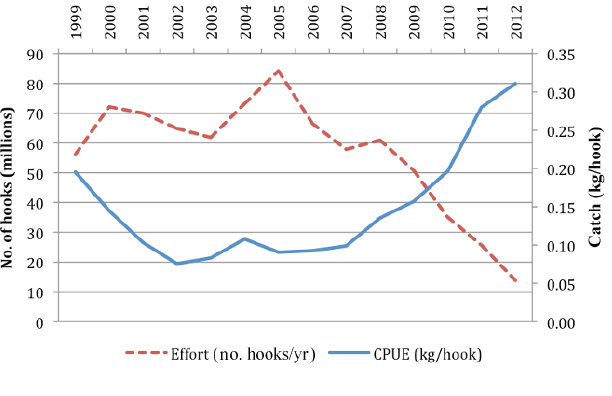
Fig. 3 . Effort and commercial catch per unit of effort (CPUE) in the Namibian hake longline fishery, 1999 to 2012. Data source: commercial logbook data, Namibia Ministry of Fisheries and Marine